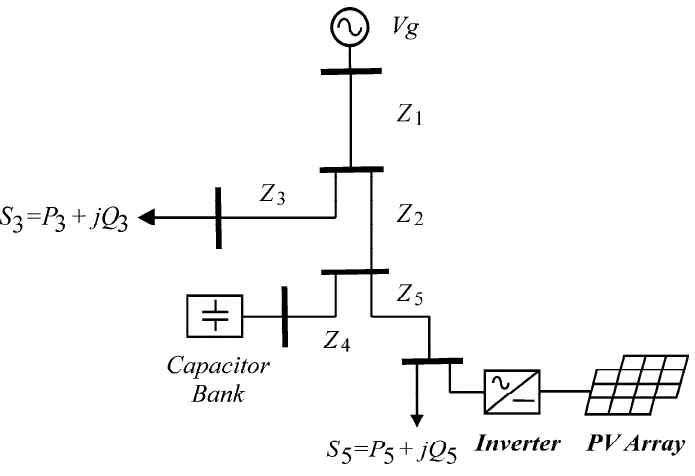
Figure 7. Microgrid supplied by a PV source.